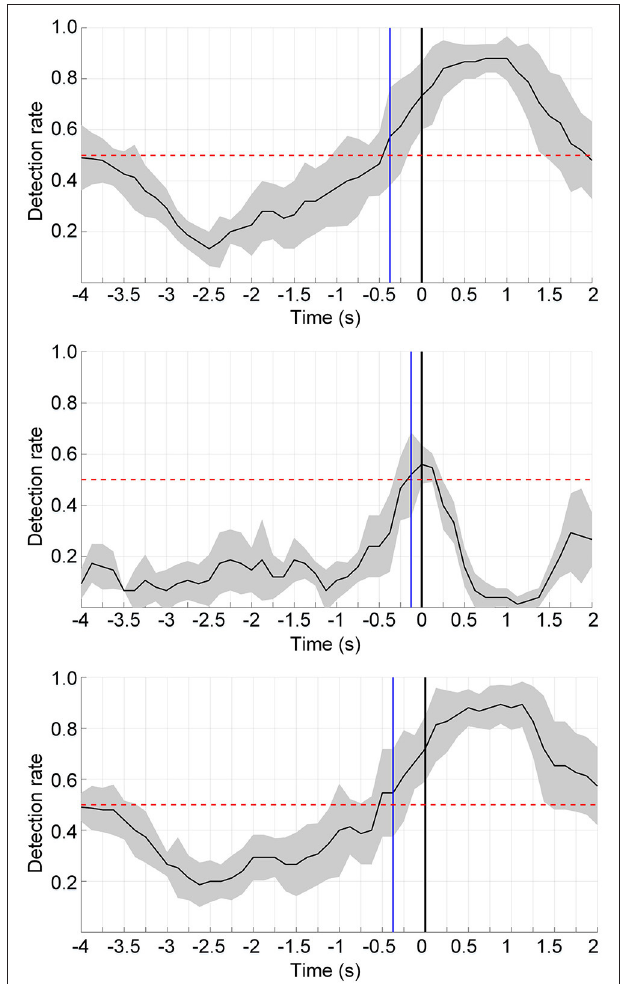
FIGURE 5 | Single-trial detection performance using the MRCP-based method (upper) , the SMR-based approach (middle) , and the concatenate model combining MRCPs and SMRs (lower) from a typical subject (s10). The detection was performed from − 4 to 2 s with respect to the actual movement onset. The blue lines display the detection points when consecutive 3 samples have a detection rate significantly above the chance level ( p < 0.05). The chance level is shown in red dashed lines. The black curves and gray regions depict the mean and standard deviation of the detection